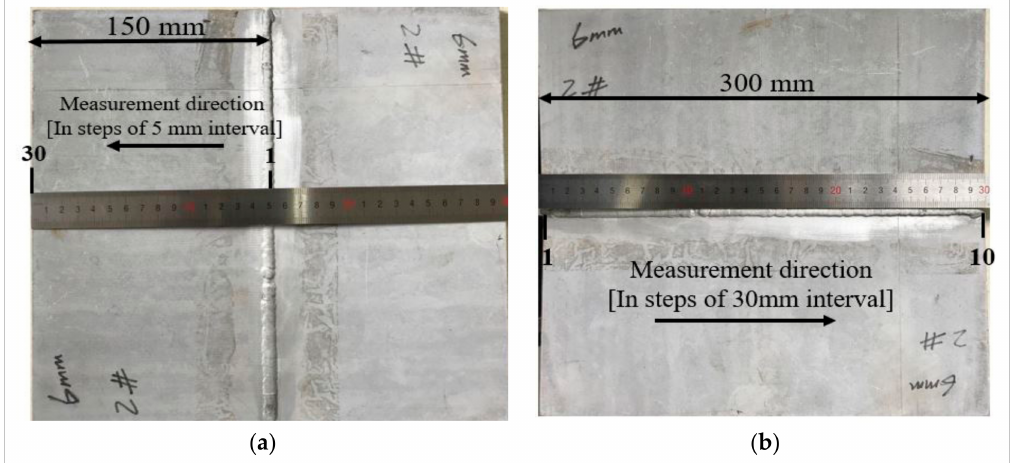
Figure 13. Residual stress measurement location and direction ( a ) residual stress measurement in transverse direction ( b ) residual stress measurement in longitudinal.